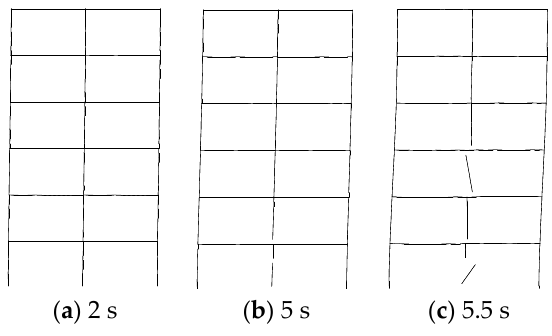
Figure 25. Failure processes of the steel frame with semi-rigid connection.